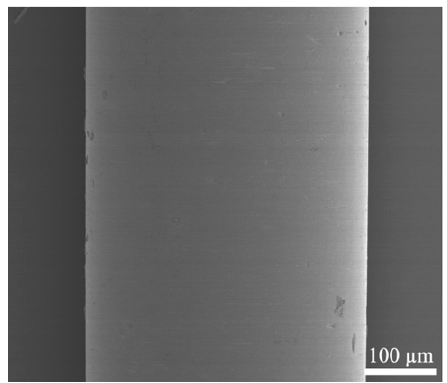
Figure 1. The SEM image of the indenter